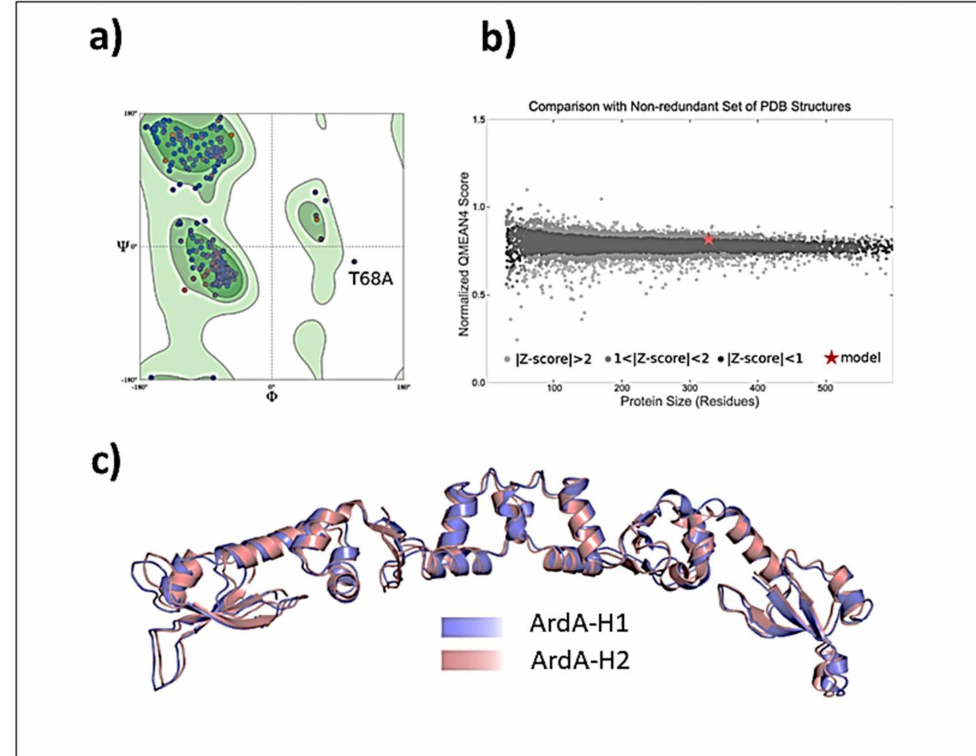
Figure 8. ( a ) MolProbity Ramachandran plot with the outlier residue Thr78 from chain A located outside the allowed regions. ( b ) QMEANDisCo plot. ( c ) ArdA-H1 (purple) superposed with the ArdA-H2 structure used as a template (PDB code 2W82, colored